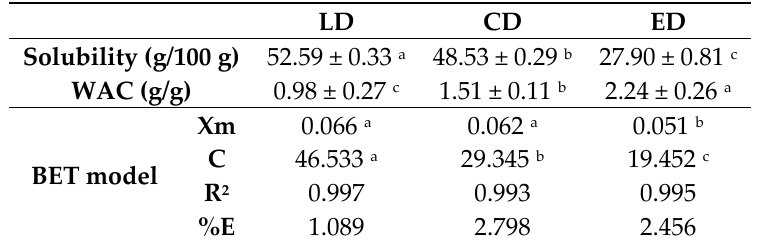
Table 2. Rehydration properties of the powders obtained by different